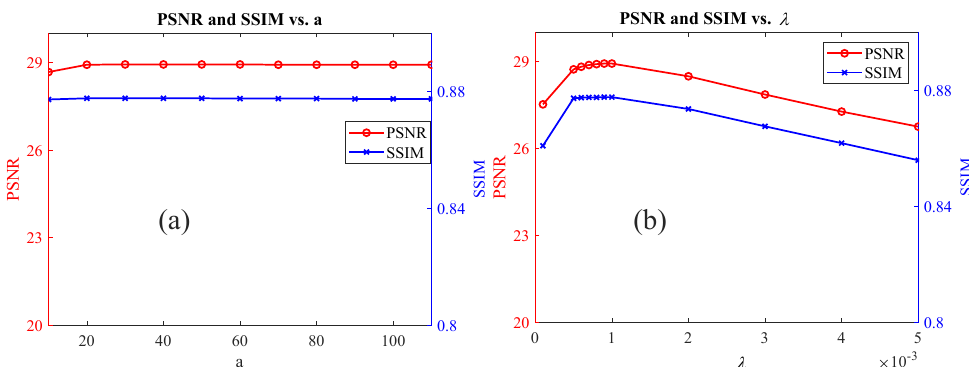
Figure 11. Variation of PSNR and SSIM values with changes in the parameters a ( a ) and λ ( b ) for image restoration.